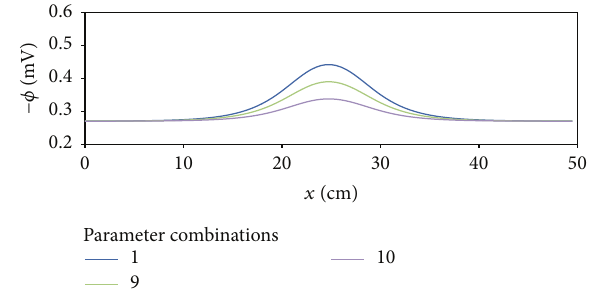
Figure5:Electricalpotentialprofileonconcretesurfacefordifferent concrete conductivities.